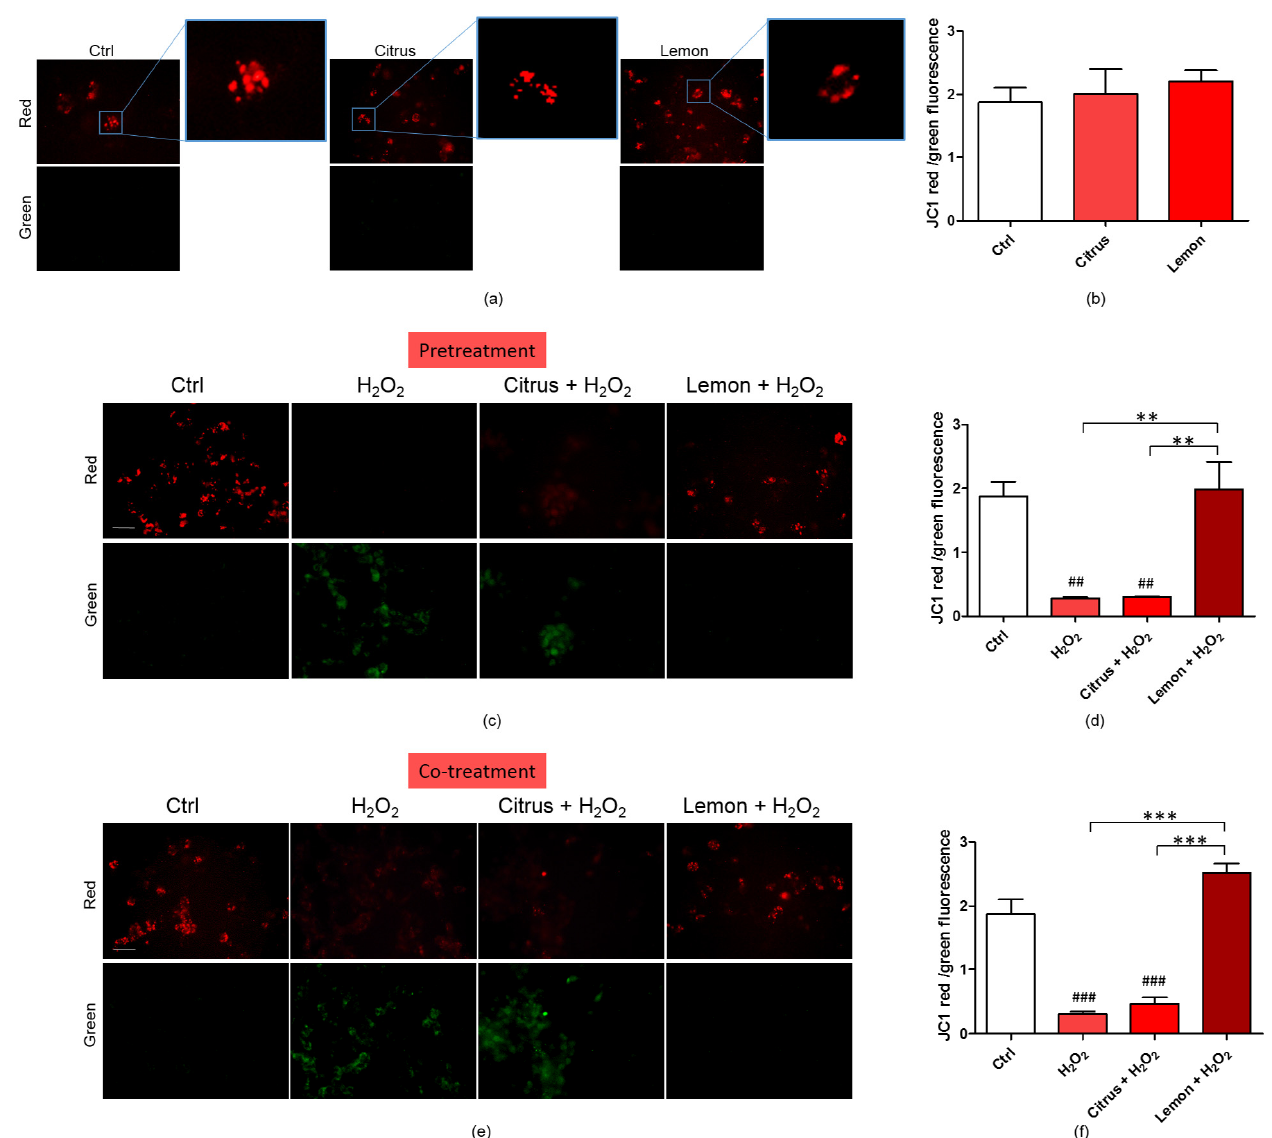
Figure 5. Effects of commercial (citrus) and lemon IntegroPectin (lemon) pectins on JC-1 red and green fluorescence affected by exposure to aqueous H 2 O 2 : ( a ) Fluorescence microscope inspection of cells treated with pectins alone submitted to JC-1 assay, the magnifications highlight the shape of the mitochondria, ( b ) histogram representing the ratio between red and green fluorescence intensity; ( c ) Fluorescence microscope inspection of cells untreated (Ctrl), treated with H 2 O 2 alone, or pretreated with pectins and then with H 2 O 2 submitted to JC-1 assay; ( d ) histogram representing the ratio between red and green fluorescence intensity in pretreatment experiment; ( e ) fluorescence microscope examination of cells untreated (Ctrl), treated with H 2 O 2 alone or co-treated with pectins and H 2 O 2 submitted to JC-1 assay; ( f ) histogram representing the ratio between red and green fluorescence intensity in cotreatment experiment. Bar: 100 µ m. Tukey test: ## p < 0.01, ### p < 0.001 as compared to control (Ctrl) group; ** p < 0.01, *** p <